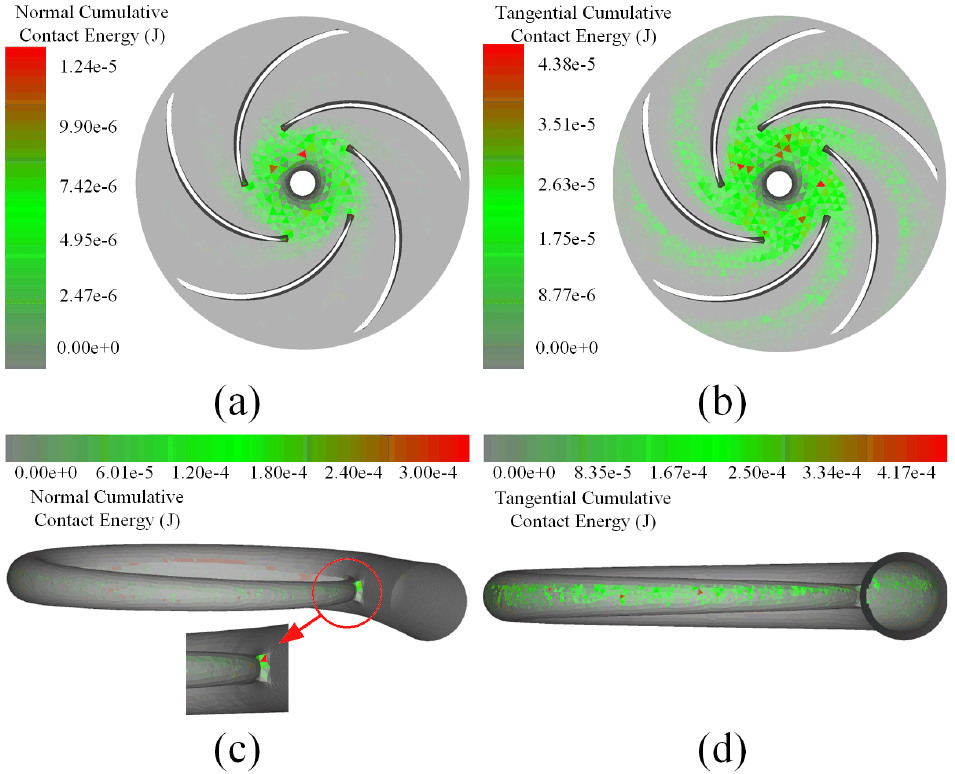
Figure 17. Schematic distribution of contact energy between impeller and volute: ( a , c ) normal cumulative contact energy; ( b , d ) tangential cumulative contact energy.